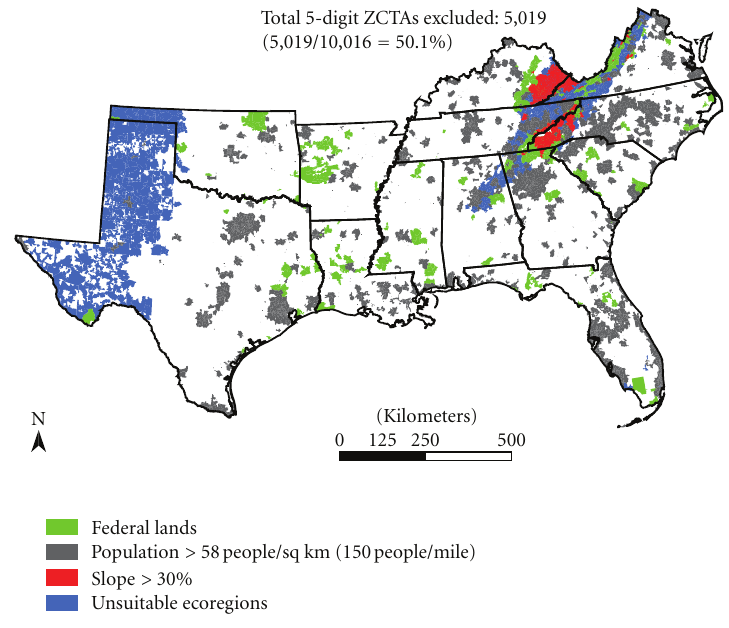
Figure 2: 5-digit ZCTAs excluded in the 13-state study region.